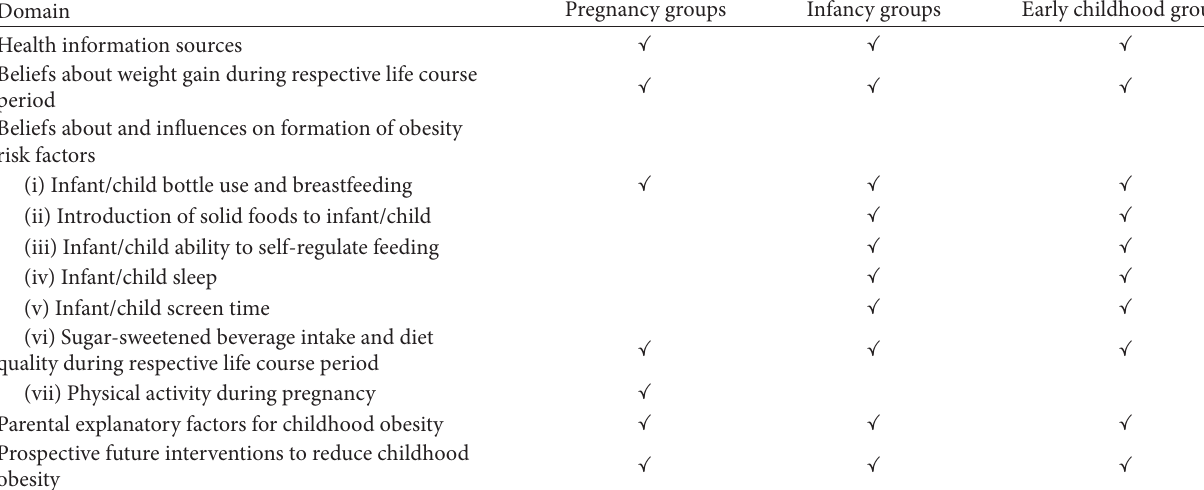
Table 1: Focus group discussion guide domains according to focus group